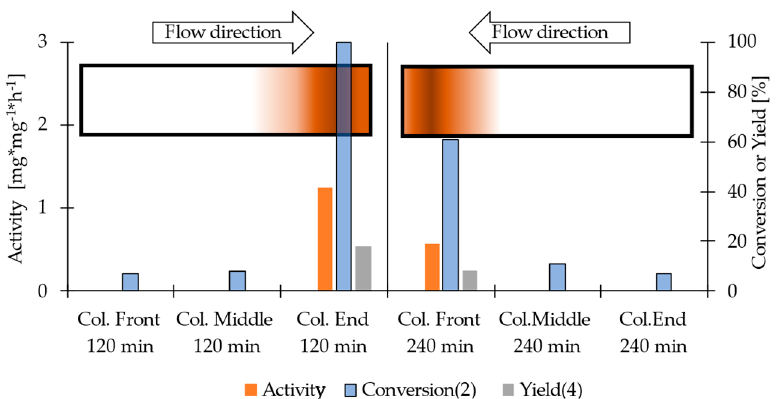
Figure 5. Activity (in mg ( 4 )*mg (dry catalyst) − 1 *h − 1 ), vinylphenol 2 conversion (secondary axis) and 4-hydoxystilbene 4 yield (secondary axis) of samples from di ff erent spatial positions of the catalyst bed; sampling after 120 and 240 min; flow direction inversion after 120 min; position of active species represented by shades of orange.